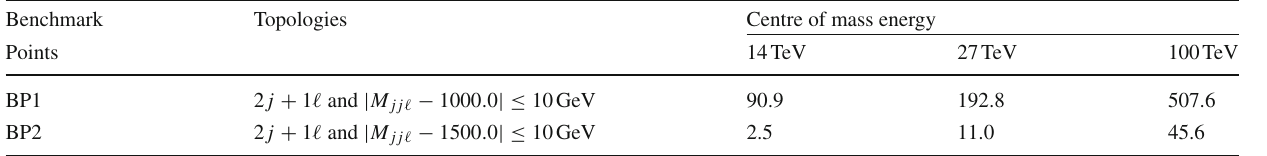
14 TeV Table 9 The number of events in M bb (cid:5) distributions for N + N − after the window cuts around the mass peak at the LHC/FCC for the benchmark points at the centre of mass energies of 14 TeV, 27 TeV and 100 TeV at the integrated luminosities of ( L int = ) 3000 fb − 1 , 1000 fb − 1 and 300 fb − 1 respectively with Y N = 5 × 10 − 7 Table 10 The number of events in M jj (cid:5) distributions after the window cuts around the mass peak at the LHC/FCC for the benchmark points at the centre of mass energies of 14TeV, 27TeV and 100TeV at